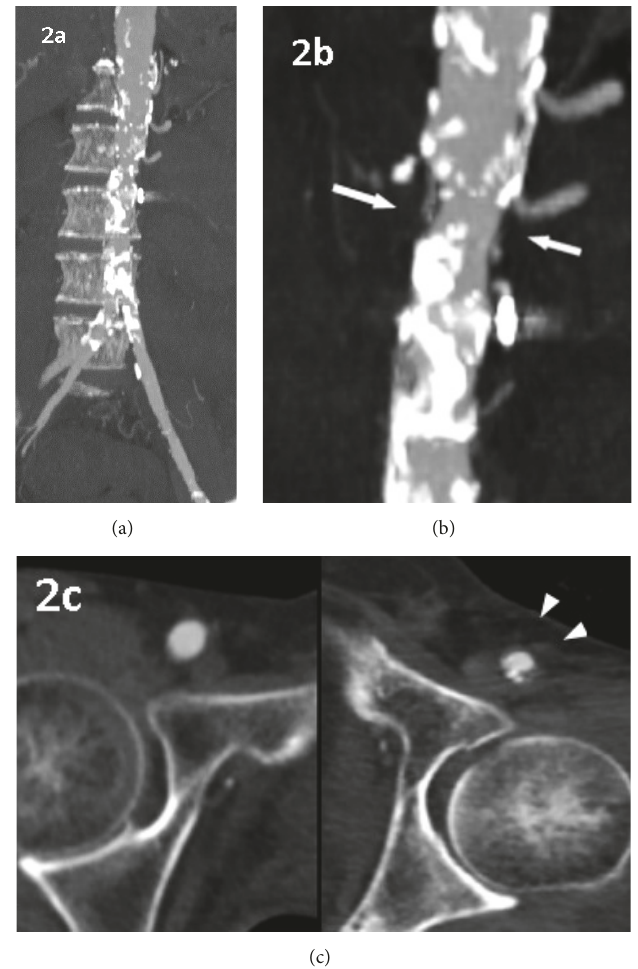
Figure 2: Maximum intensity projection reconstruction of coronal computed tomography angiogram and transverse plane at the level of inguinal region on admission. (a) Diffuse calcification from the abdominal aorta to the left common iliac artery was observed, which was confined to the irradiation field. ((b) and (c)) Irregular stenosis of the abdominal aorta (white arrows) and left femoral artery